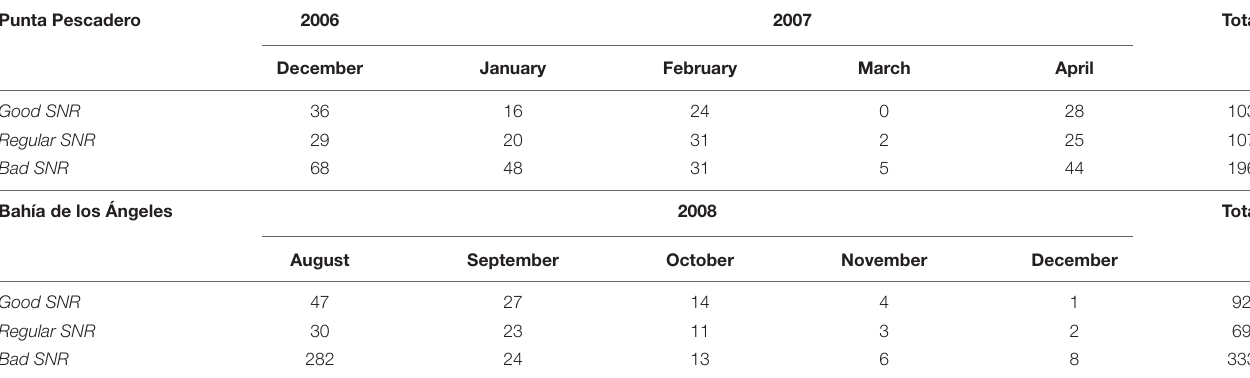
FIGURE 4 | Example of a Bryde’s whale’s Be4 call (right) and its immediate background noise (left) at Punta Pescadero, Baja California Sur. Spectrograms 2D on the top and their respective power spectrum on the bottom. Spectrograms: Hamming window size 2048, 85% overlap, and a frame of 4096. Power spectra: Frequency resolution 1.9536 Hz. TABLE 1 | Number Be4 calls of Bryde’s whale detected by signal-to-noise ratio (SNR) in recordings by the site. Punta